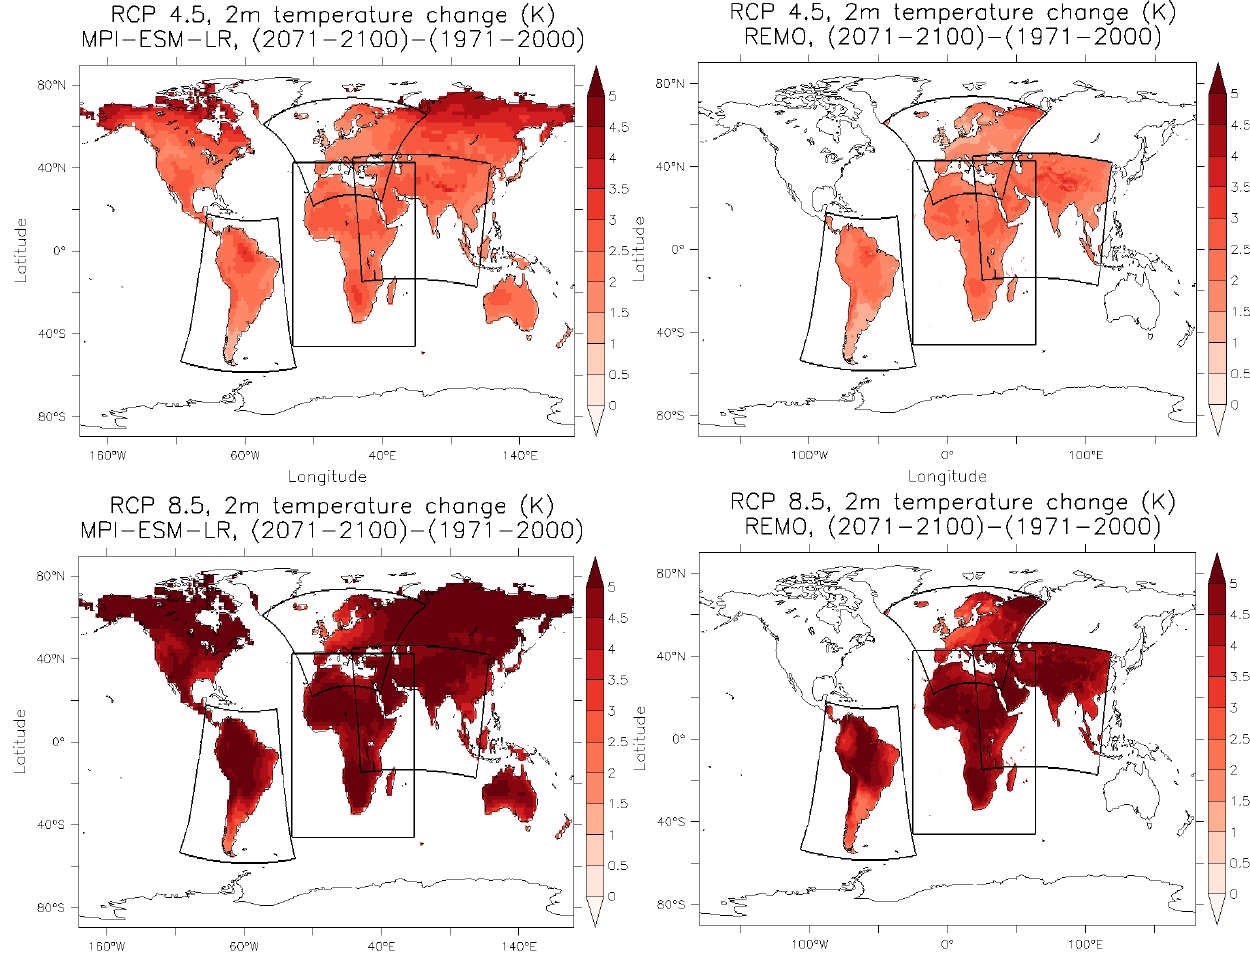
Figure 3. MPI-ESM (LR) and REMO climate change signals for annual mean